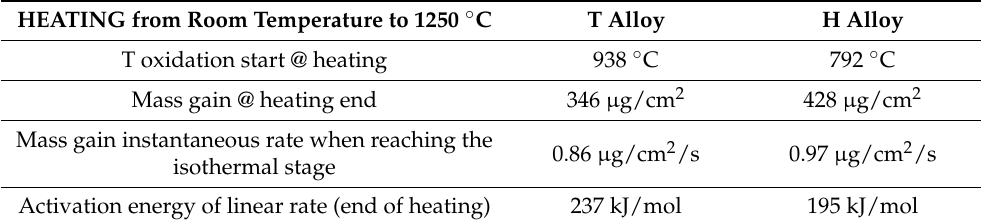
Table 4. Values of various parameters characterizing the oxidation during heating for the two